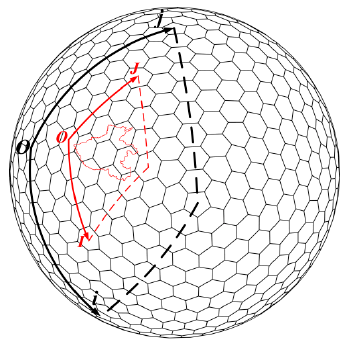
Figure 10. Schematic diagram of the DGGRID indexing algorithm.